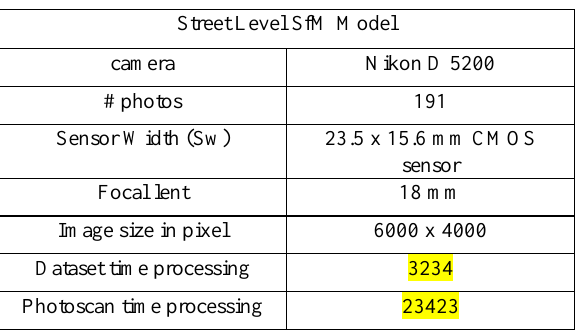
Table 10. Street Level SfM Model features